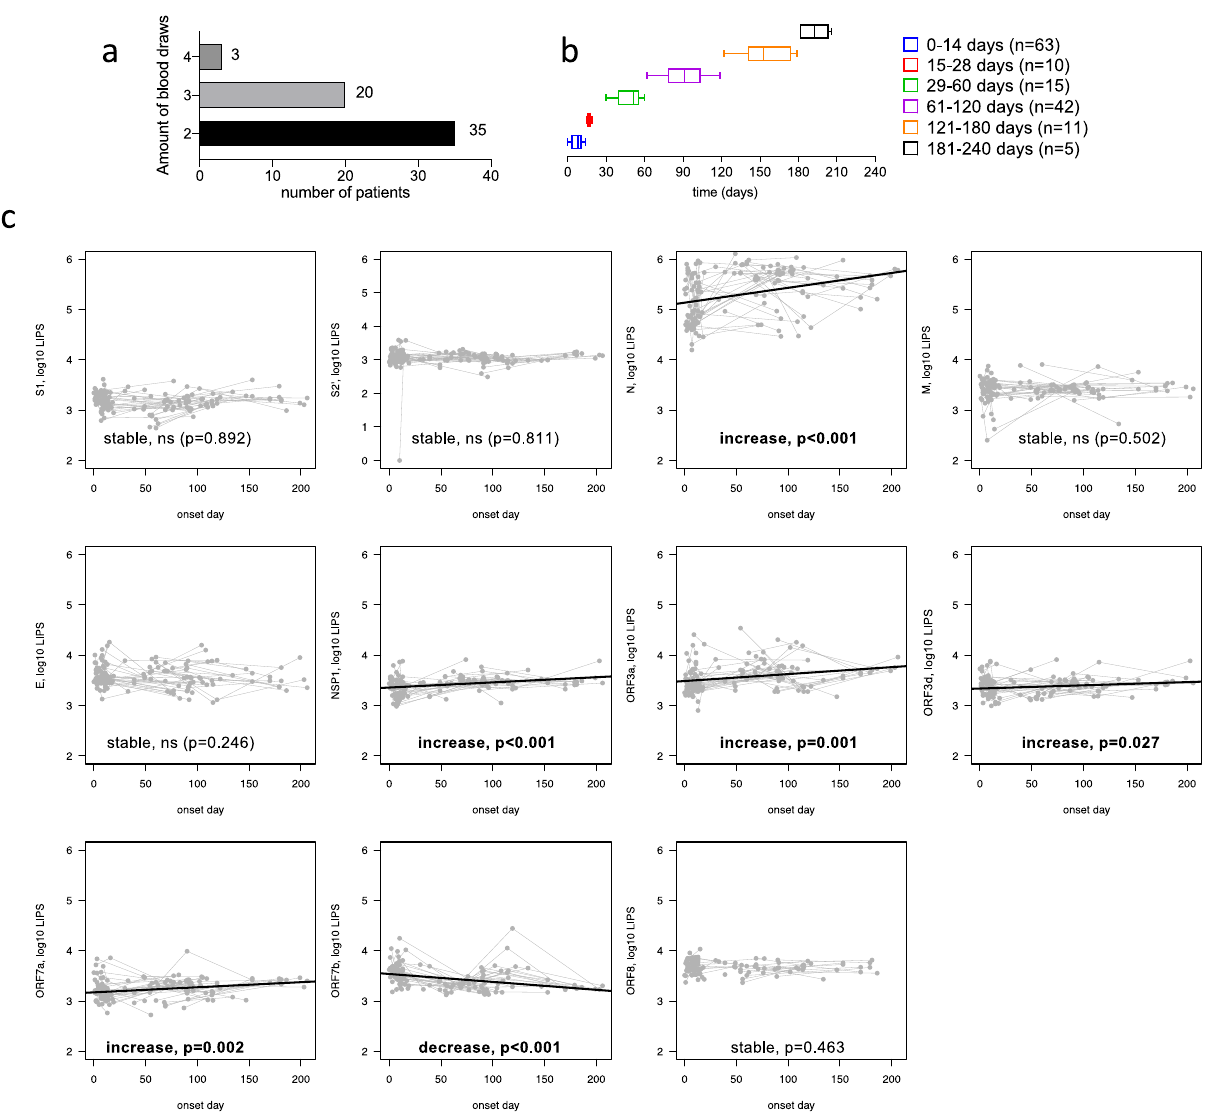
Fig. 6 Longitudinal stability of antibody responses for structural and non-structural SARS-CoV-2 proteins in COVID-19 children. a Number of longitudinal patients with either 2, 3, or 4 blood draws from 58 pediatric COVID-19 cases. b Sample collection time-line (days post infection). For each plot, whiskers are minima to maxima, and center is mean, no percentile is shown. Detailed minima, maxima, mean ± S.D. are as follows: Days 0 – 14:0,